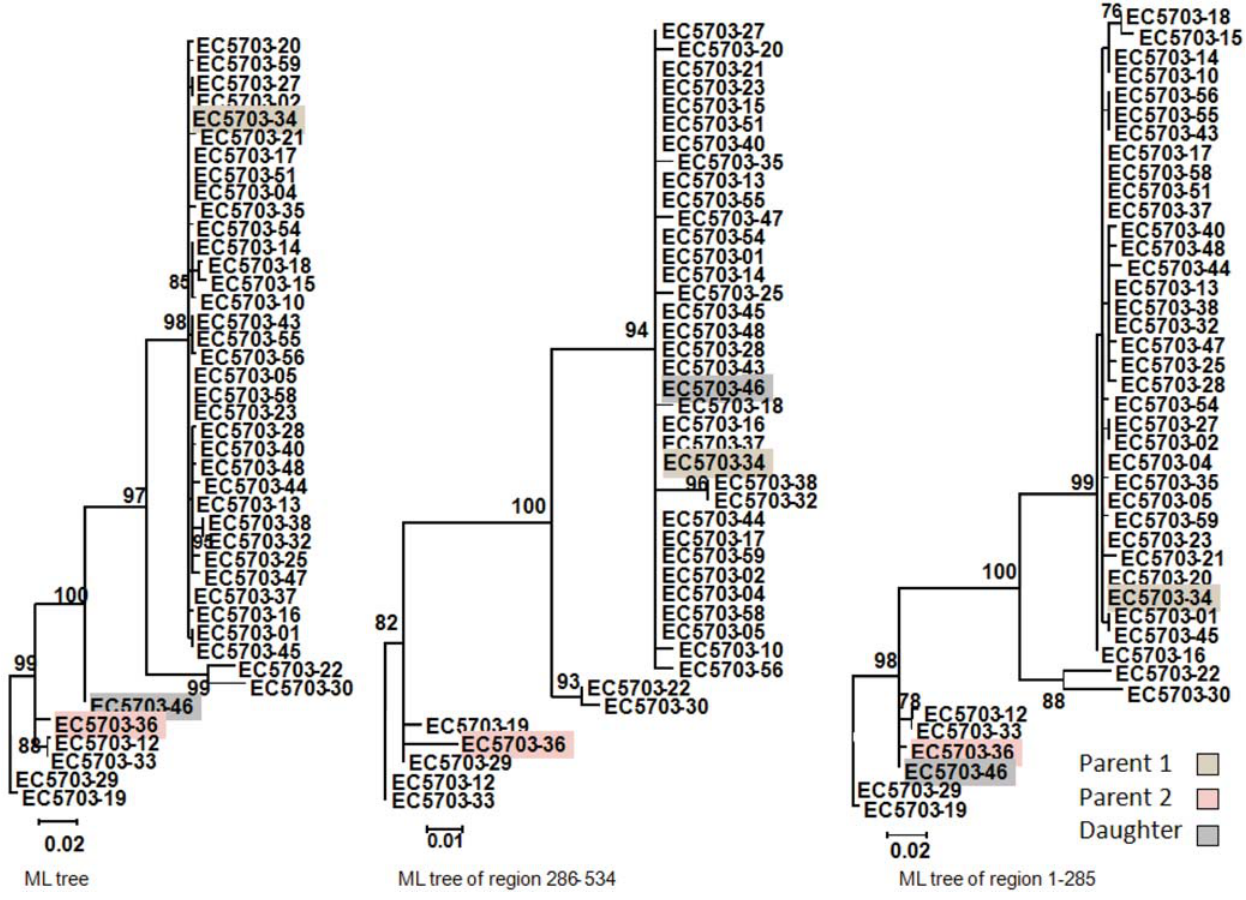
Figure 6. Example of recombination detection in the E1E2 region (EC5703 sample). The phylogenetic tree on the left corresponds to the analysis of the complete region whereas the other two are derived from the two regions defined by the detected recombination event.